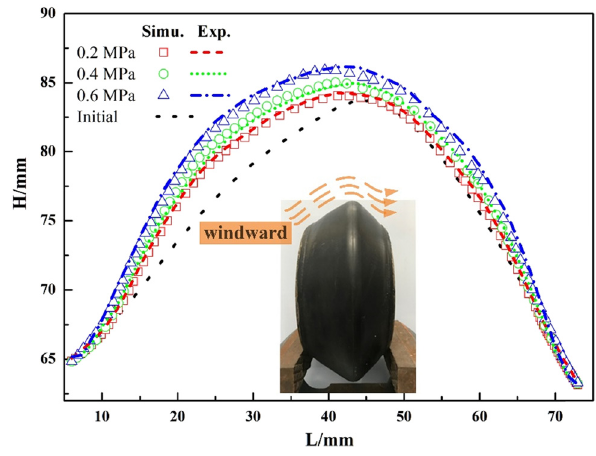
Figure 16: Comparison of test and simulation under di ff erent